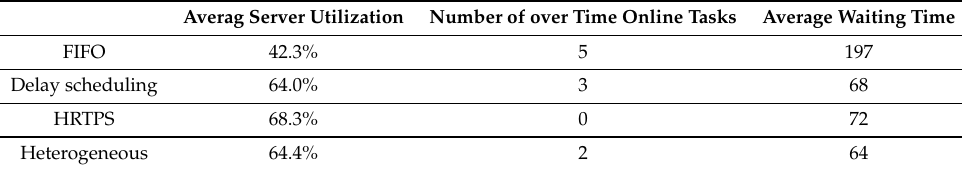
Table 5. Comparison of three methods in three aspects (time